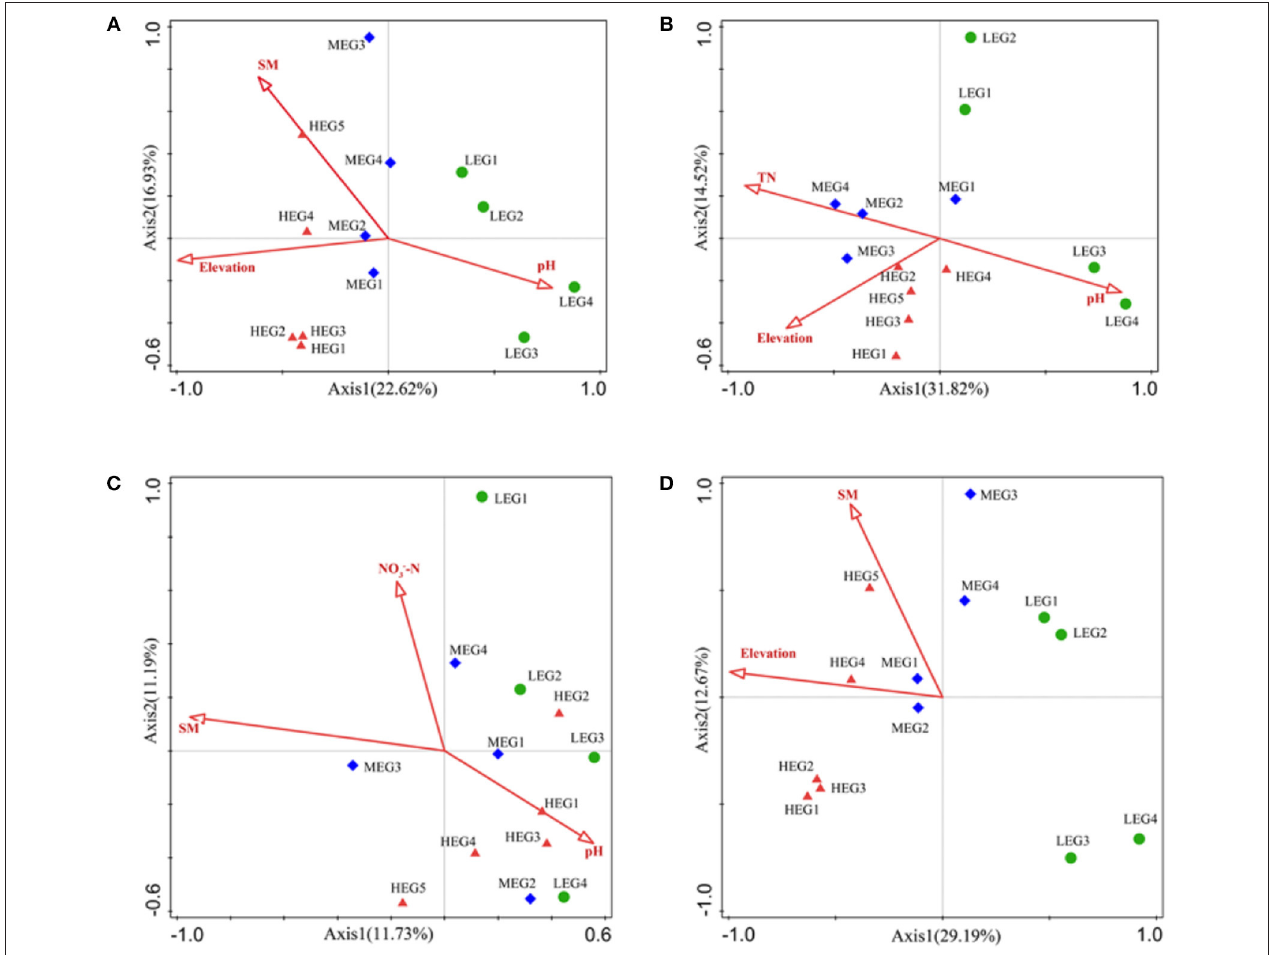
FIGURE 6 | RDA or CCA of the soil microbial community structure and environmental variables. (A) All; (B) Generalists; (C) Specialists; (D) Other taxa. Only the environmental variables which were significantly correlated with RDA1, or CCA1 were shown in figures. High elevational gradient (HEG) (2900–3055m) including five different elevation sampling sites (HEG1, HEG2, HEG3, HEG4, and HEG5), both medium elevational gradient (MEG) (2500–2800m) (MEG1, MEG2, MEG3, and MEG4) and low elevational gradients (LEG) (2000–2300m) (LEG1, LEG2, LEG3, and LEG4) including four different elevation sampling